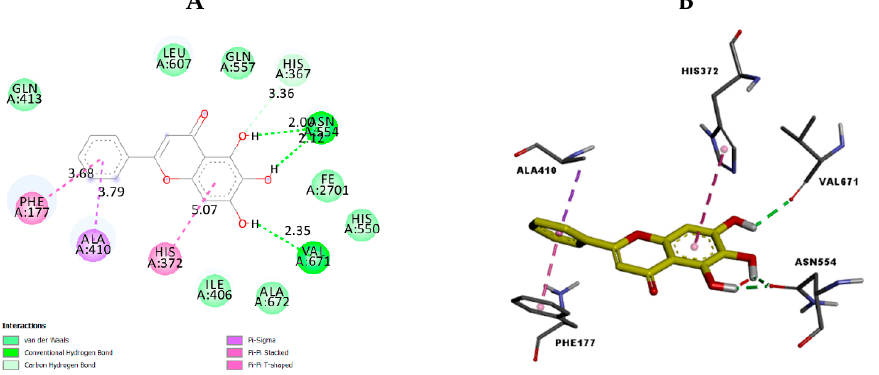
Figure 5. The 2D ( A ) view and 3D ( B ) view of the interaction type of M17 with the surrounding amino acids of xanthine oxidase.